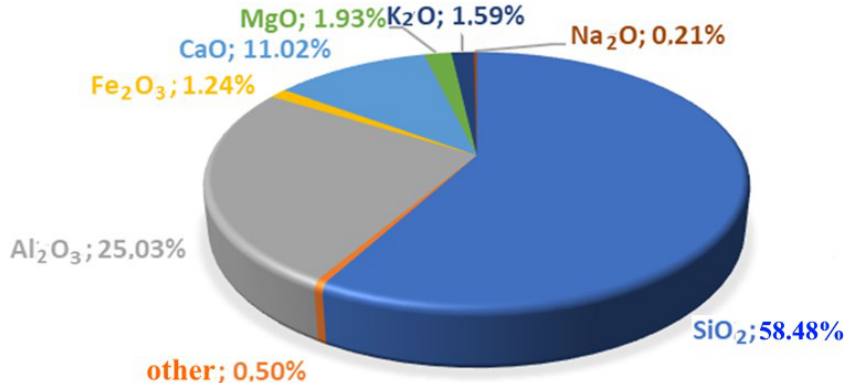
Figure 13. Chemical composition of the obtained aluminosilicates.